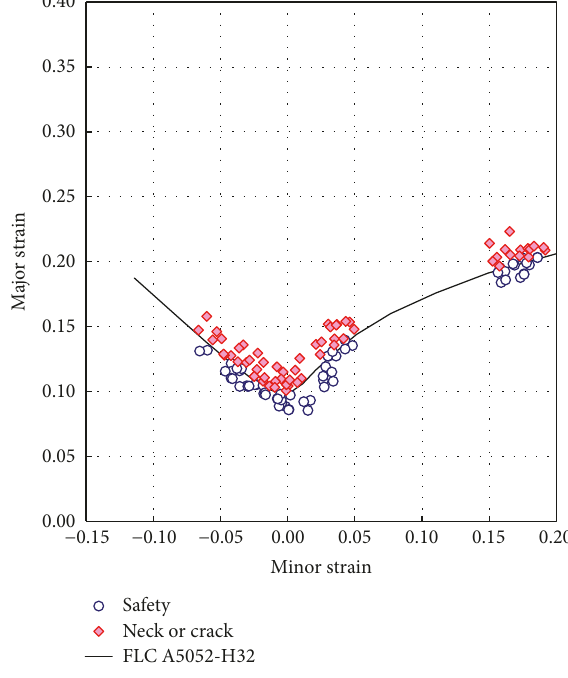
Figure 5: FLD of